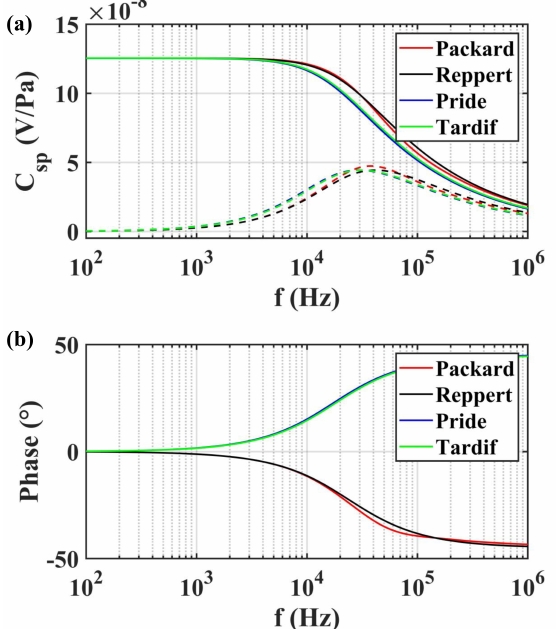
Figure 7. The relationships between the experimental permeability and permeability predicted by different models: ( a ) capillary bundle model; ( b ) Kozeny–Carman.